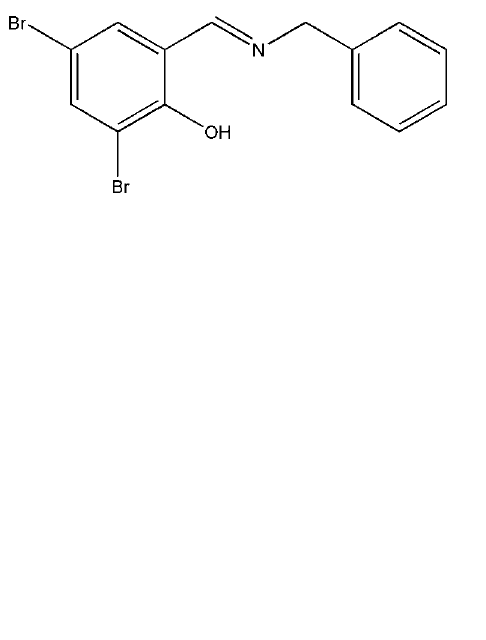
Schiff base compounds, see: Cohen et al. (1964).